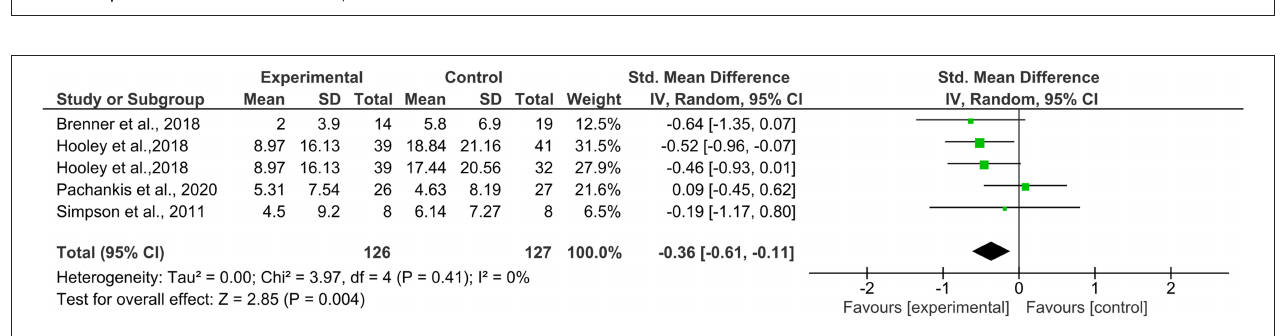
FIGURE 3 | Effects on suicidal ideation at post-intervention.